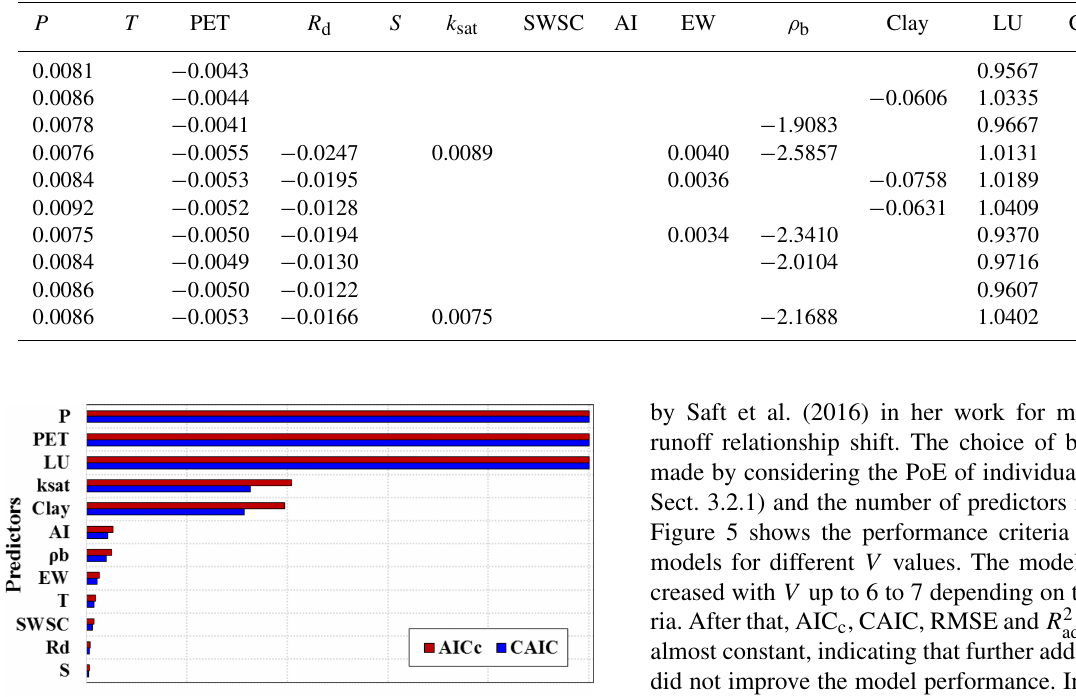
Table 3. Coefficient of predictors used in the top 10 models, ranked based on CAIC.